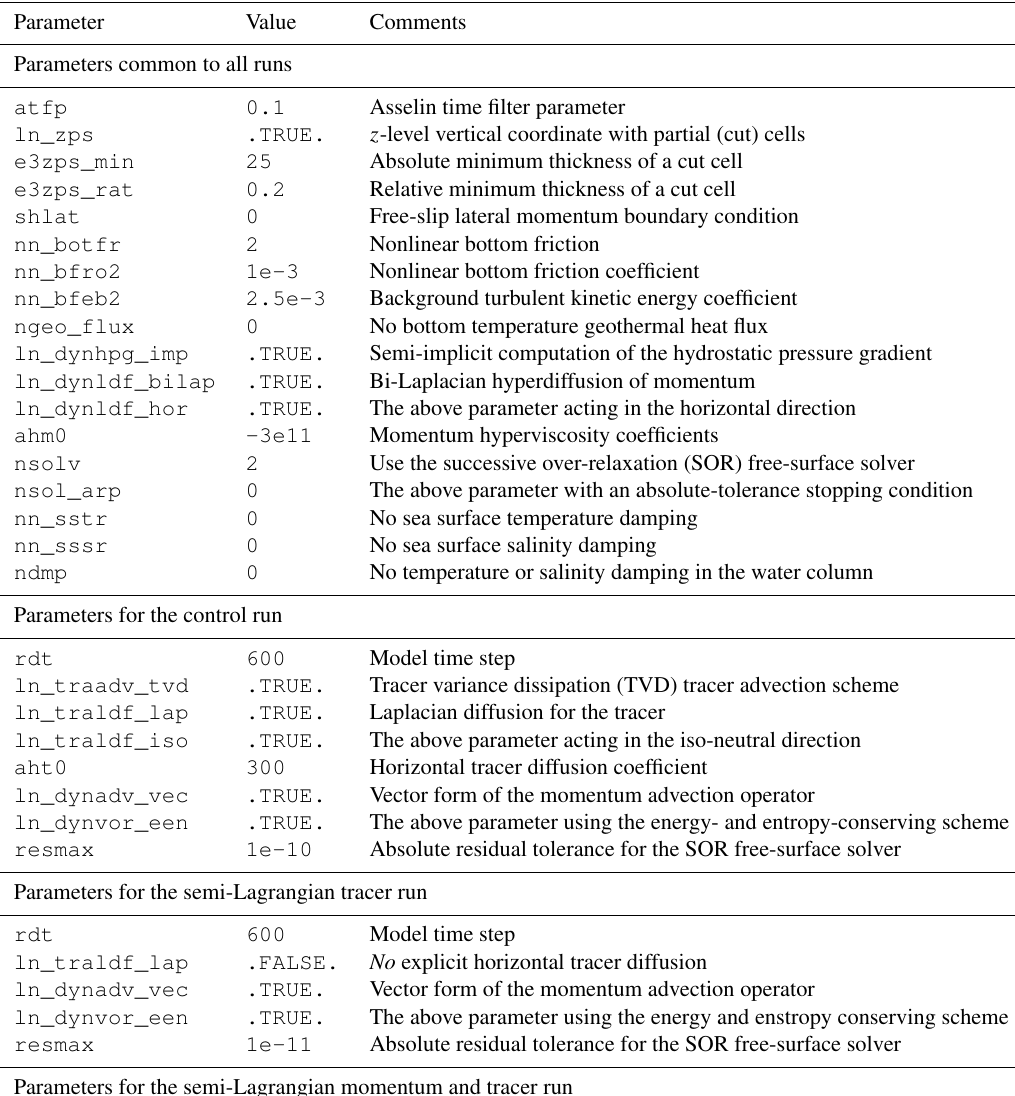
Table 2. Selected dynamical and numerical namelist parameters for the test cases of Sect. 5.2. Parameter